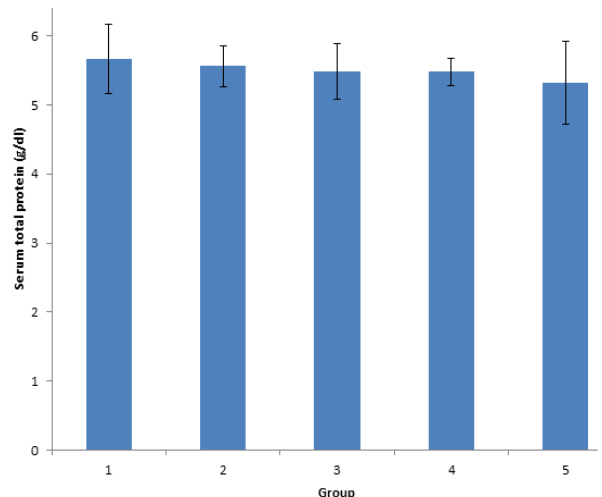
Fig. 3. Effects of administration of varying concentrations of quail egg solution on the serum total protein of alloxanized rats